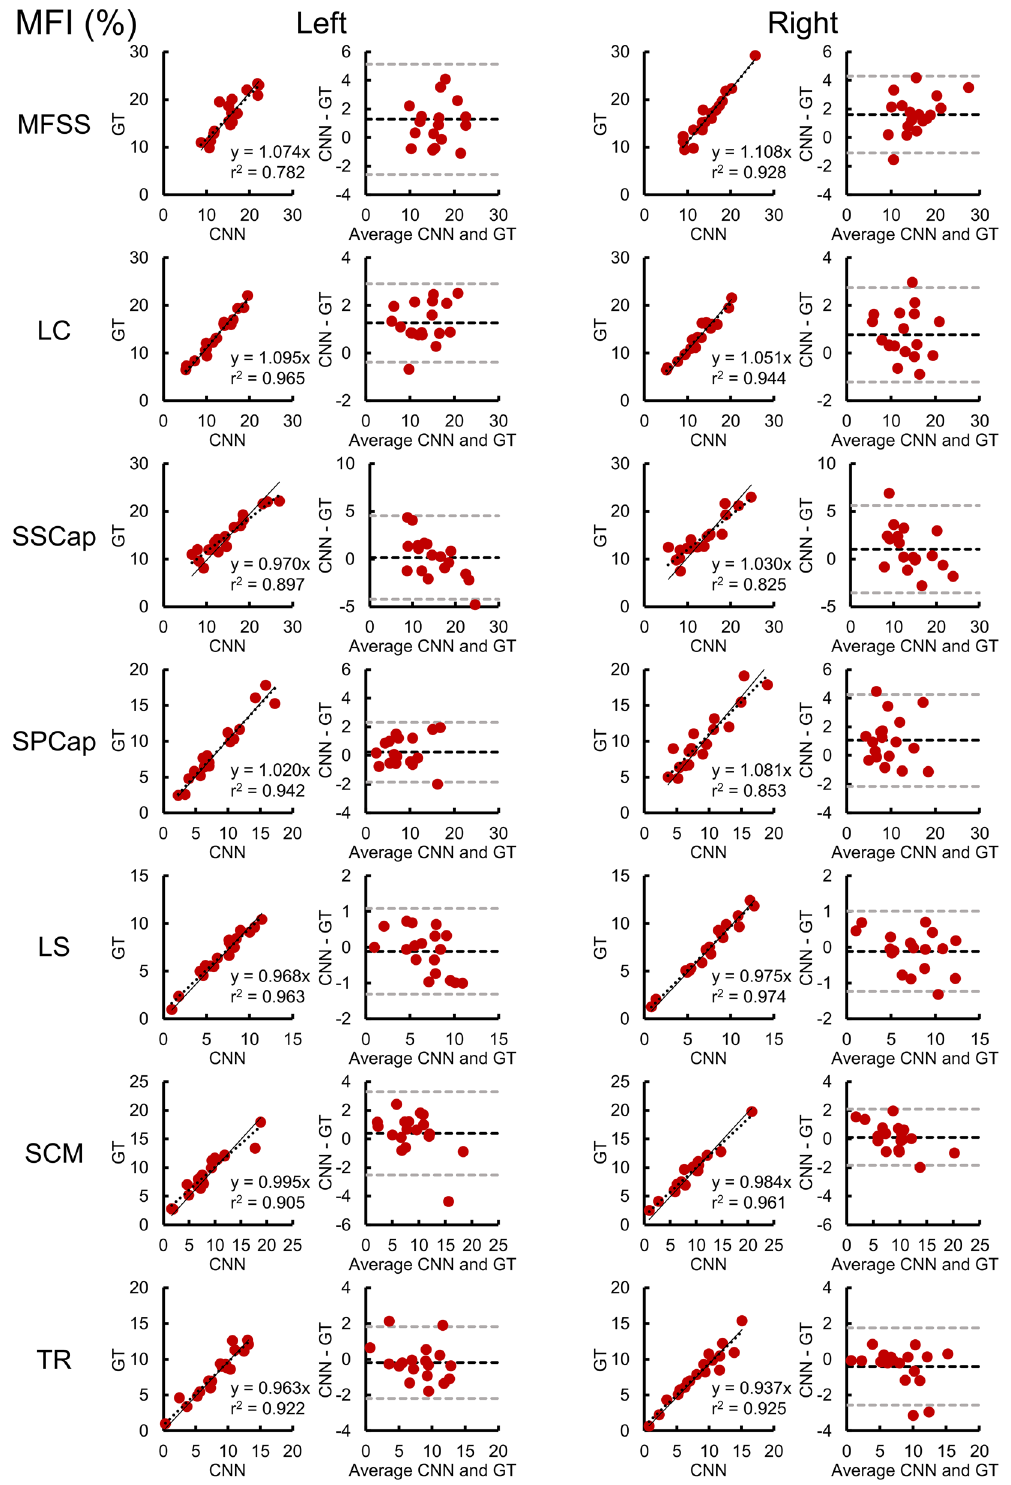
Figure 3. Reliability and accuracy of the convolutional neural network (CNN) muscle fat infiltration (MFI) measures on the testing dataset (n = 18). Correlation and Bland-Altman plots are shown for MFI for each of the muscle groups. In the correlation plots, the dashed black line represents the best fit line, and the linear regression coefficient (β) of the ground truth (GT) on CNN (intercept = 0) is also provided (solid black line), which can be used to correct the CNN measurement bias. In the Bland-Altman plots, the dashed black and gray lines indicate the mean difference (i.e., bias) ± 1.96 × standard deviation (i.e., 95% limits of agreement). See Table 3 for the intraclass correlation coefficients (ICC 2,1